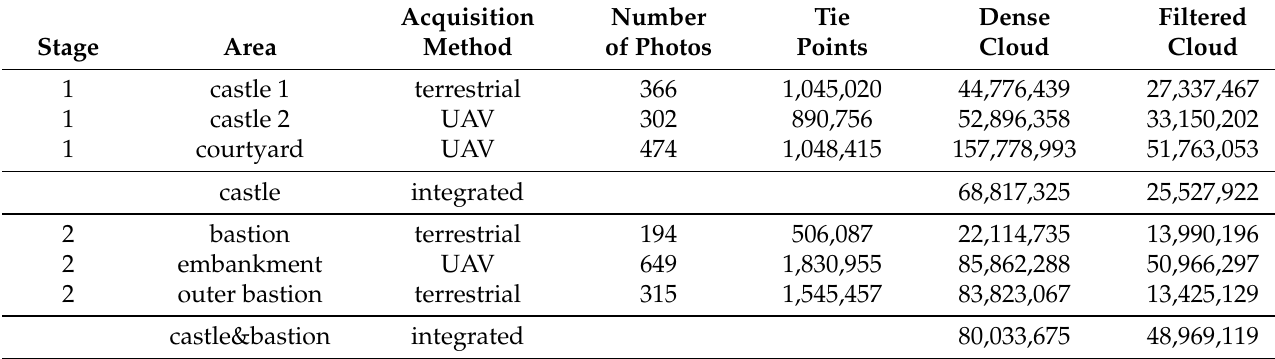
Table 1. Summary of partial